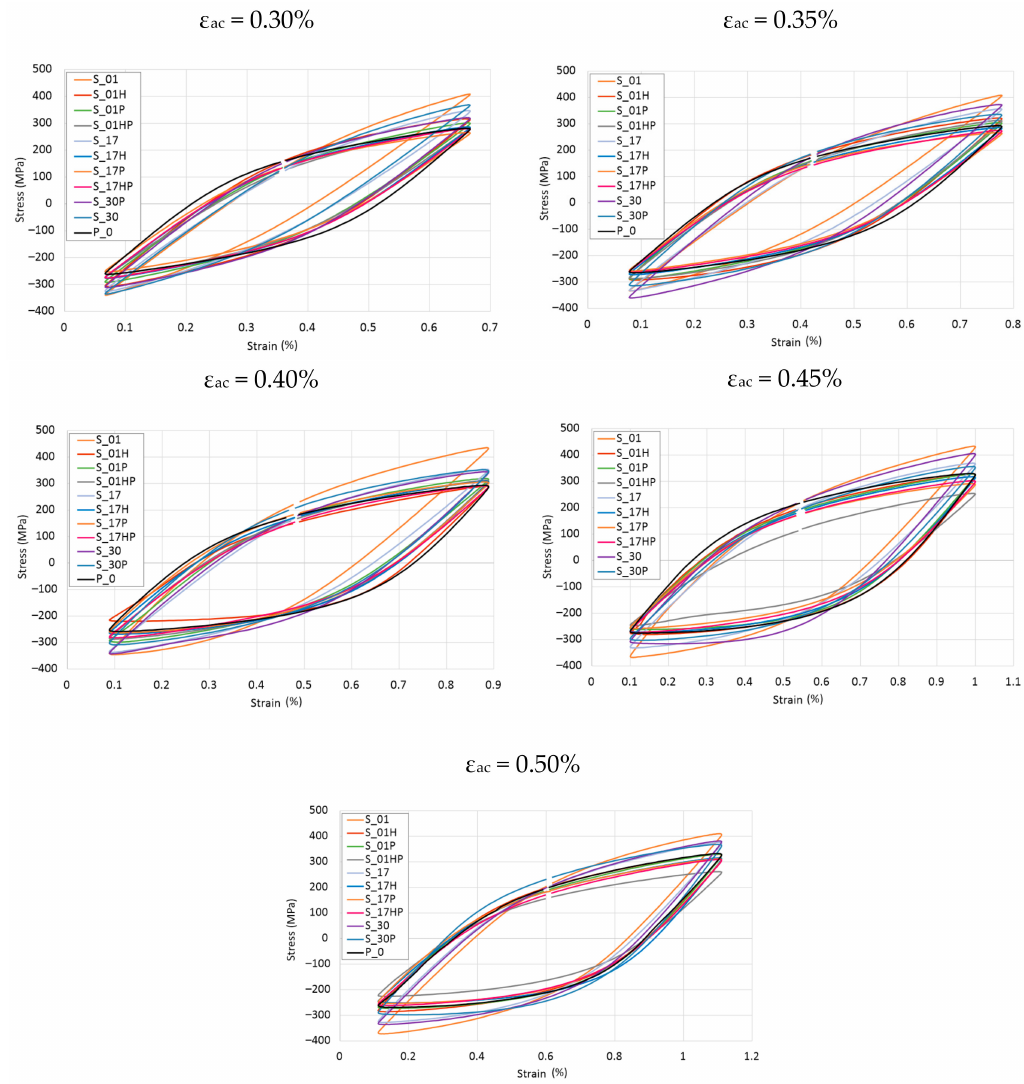
Figure 4. Mid-life hysteresis loops registered for total strain amplitudes ε ac = 0.30, 0.35, 0.40, 0.45, and